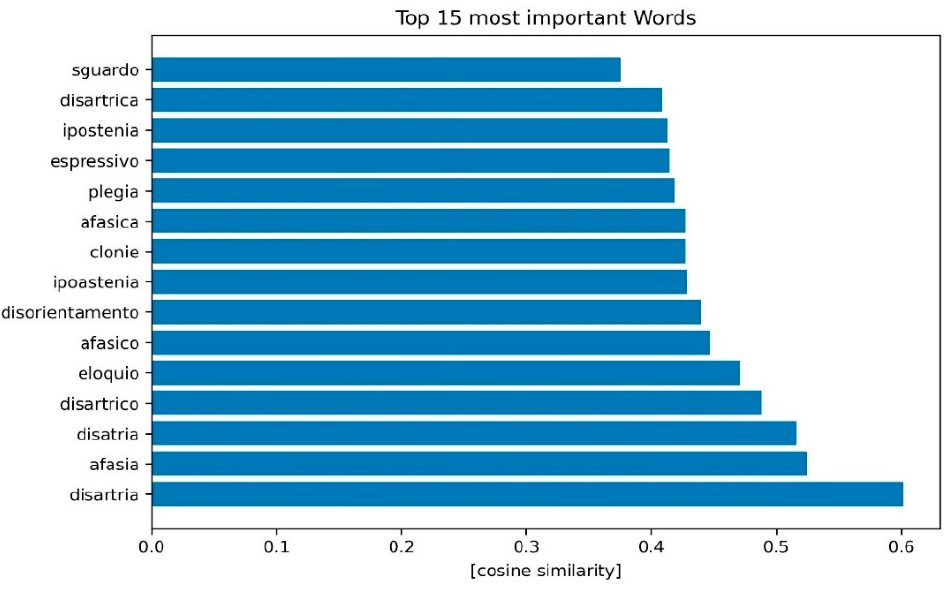
Figure 4. Top words obtained by word embedding.